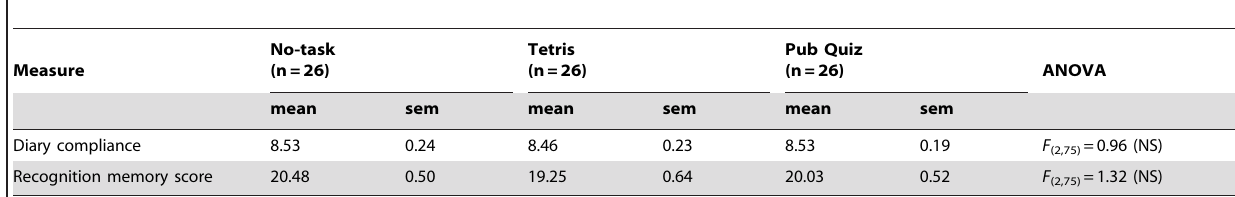
Table 10. Experiment 2 diary compliance and recognition memory after 1-week indicating equivalence across conditions.